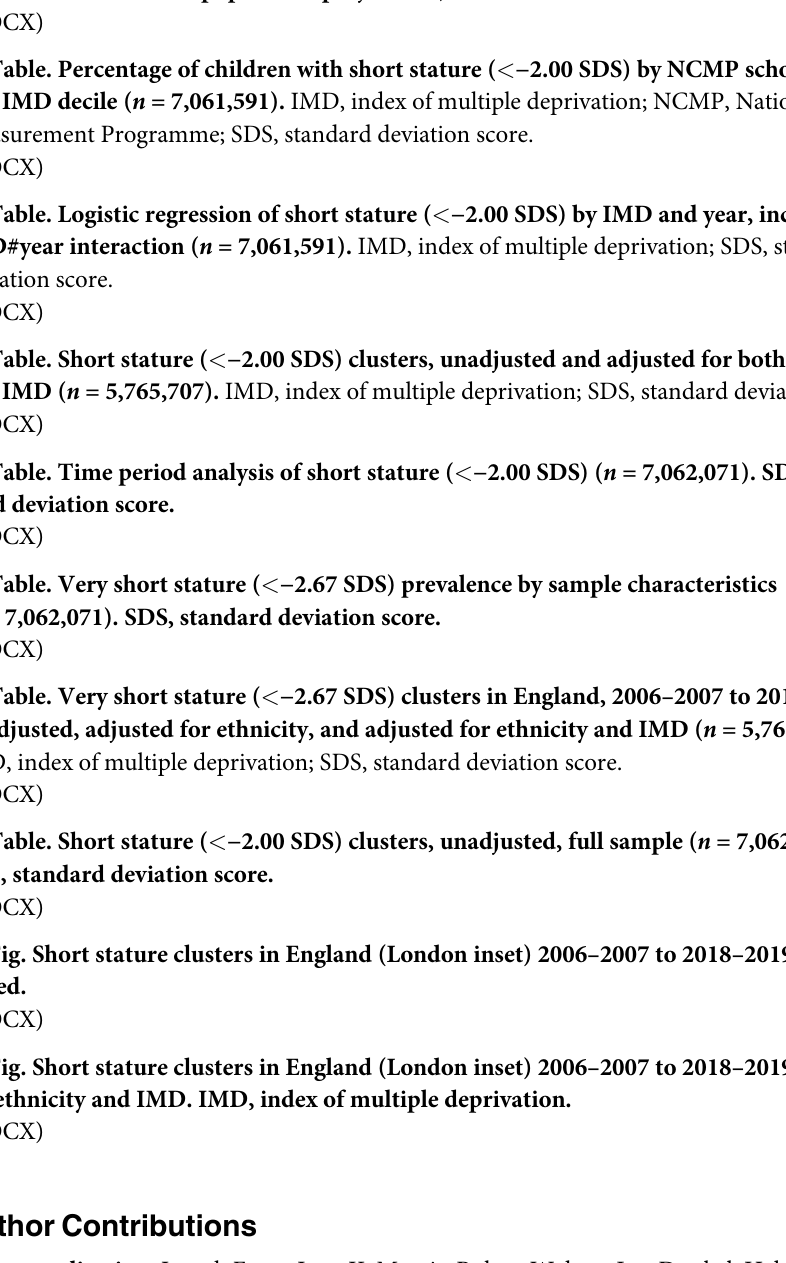
S1 Table. Ethnicity and IMD missingness by sample characteristics. IMD, index of multiple deprivation. S2 Table. Population sex, Government Office Region, and ethnicity in children, 2011–2012 (Census 2011 and ONS population projections). S3 Table. Percentage of children with short stature ( < − 2.00 SDS) by NCMP school year and IMD decile ( n = 7,061,591). IMD, index of multiple deprivation; NCMP, National Child Measurement Programme; SDS, standard deviation score. S4 Table. Logistic regression of short stature ( < − 2.00 SDS) by IMD and year, including IMD#year interaction ( n = 7,061,591). IMD, index of multiple deprivation; SDS, standard deviation score. S5 Table. Short stature ( < − 2.00 SDS) clusters, unadjusted and adjusted for both ethnicity and IMD ( n = 5,765,707). IMD, index of multiple deprivation; SDS, standard deviation score. S6 Table. Time period analysis of short stature ( < − 2.00 SDS) ( n = 7,062,071). SDS, stan- dard deviation score. S7 Table. Very short stature ( < − 2.67 SDS) prevalence by sample characteristics ( n = 7,062,071). SDS, standard deviation score. S8 Table. Very short stature ( < − 2.67 SDS) clusters in England, 2006–2007 to 2018–2019, unadjusted, adjusted for ethnicity, and adjusted for ethnicity and IMD ( n = 5,765,707). IMD, index of multiple deprivation; SDS, standard deviation score. S9 Table. Short stature ( < − 2.00 SDS) clusters, unadjusted, full sample ( n = 7,062,071). SDS, standard deviation